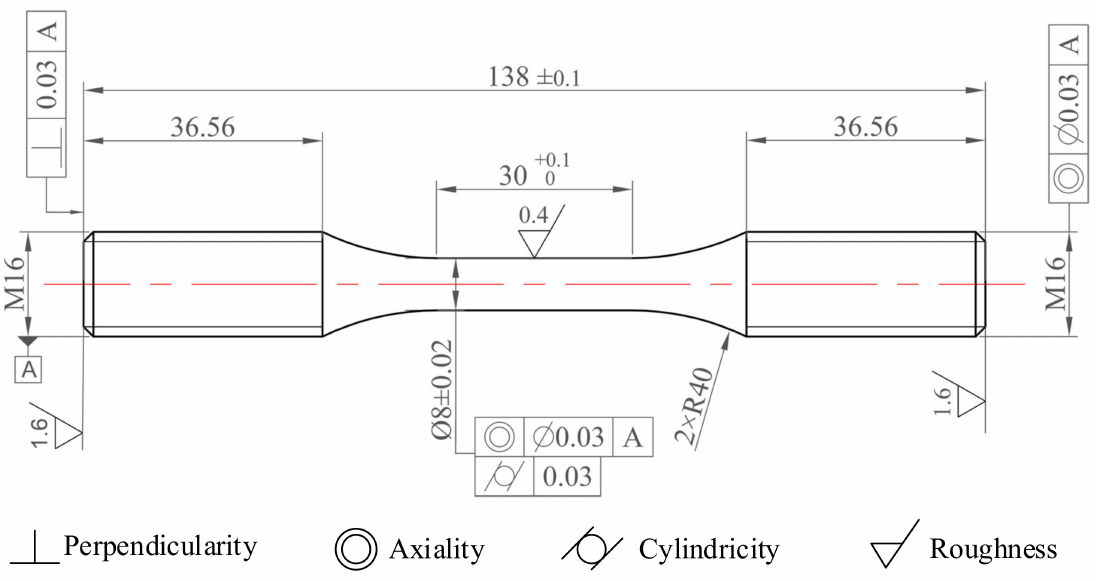
Figure 2. Geometry of the test specimen (dimensions in